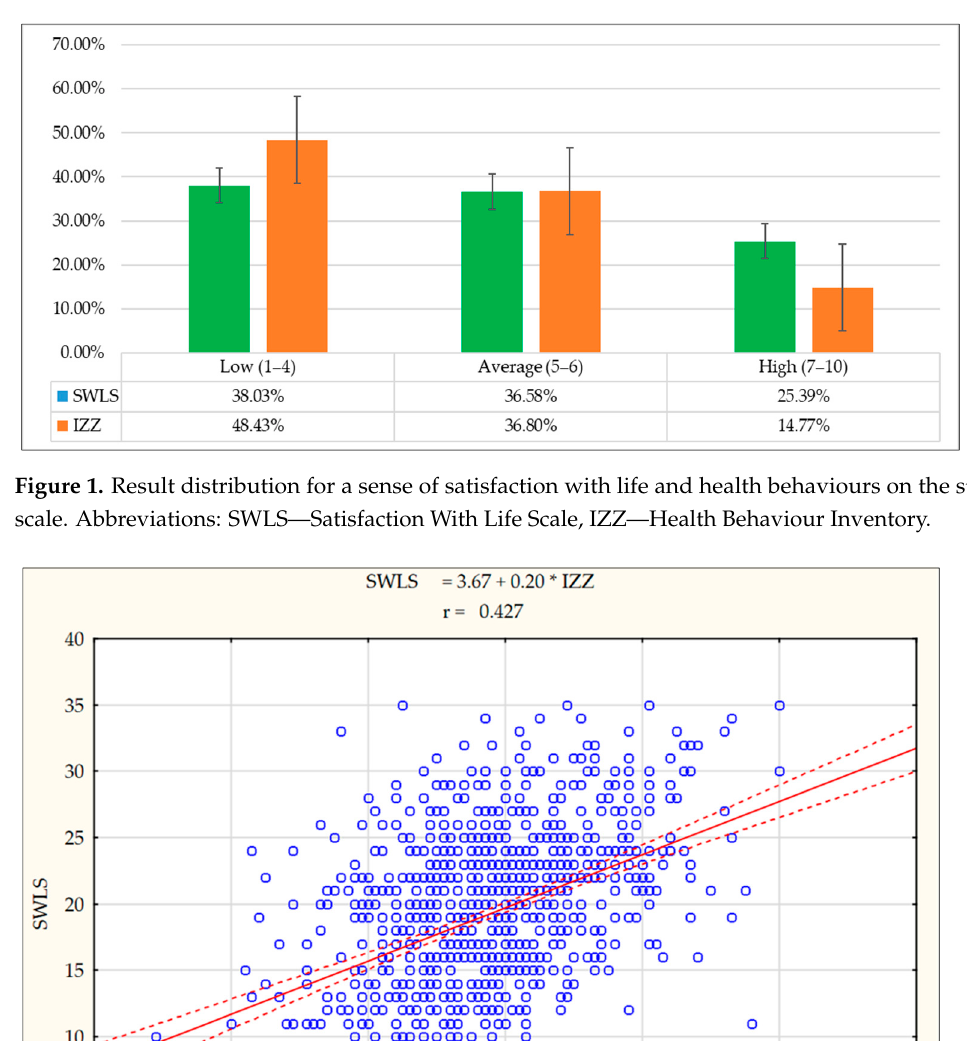
Figure 1. Result distribution for a sense of satisfaction with life and health behaviours on the sten scale. Abbreviations: SWLS—Satisfaction With Life Scale, IZZ—Health Behaviour Inventory.